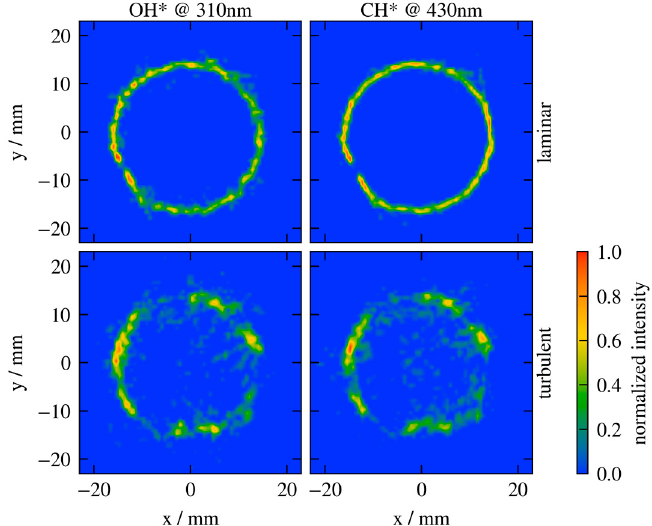
Figure 2. Simultaneously acquired, normalized species distributions of OH* (left column) and CH* (right column) in laminar (top row, CH 4 2 slm, air 10 slm, h = 5 mm, λ 1 = 5, λ 2 = 10) and turbulent (bottom row, CH 4 2 slm, air 100 slm, h = 13.3 mm, λ 1 = 5, λ 2 = 5). The exposure time is 1 ms. (slm = standard liters per minute)